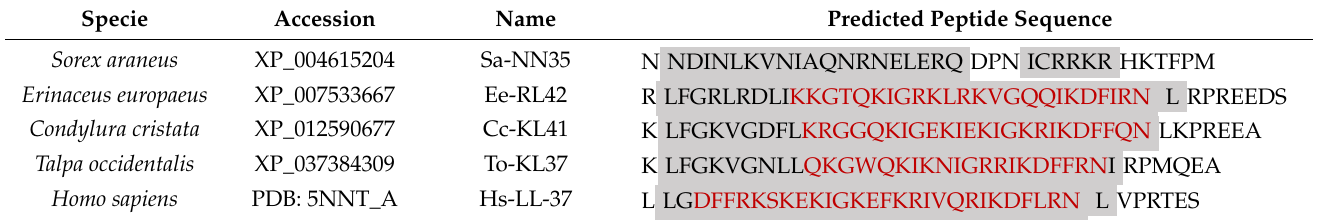
Table 1. Amino acid sequence of the putative antimicrobial peptide for the annotated cathelicidin sequences (accessed on 9 May 2022) of mammals of the Eulipotyphla order, including Talpa occiden- talis . Shaded residues correspond to the alpha helix portion of the peptide according to the models predicted with the Alphafold server. Residues in red represent the LPS binding domain of CAP18 (identified by its similarity with pfam12153).